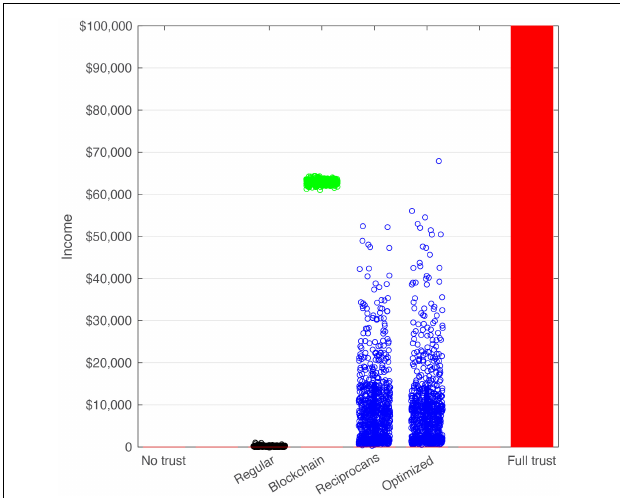
FIGURE 7 | Profit generated by the C-3PO in each simulation condition. Red bar depicts the maximum possible payoff in a 1,000-iteration game with full trust, where each agent contributes all their wages to the shared account (1,000 × $100). Dots reflect the ultimate outcome of a game played with the simulation variables. "No trust” (left) yields $0 for the C-3PO. Regular games (black) yield low gains compared to the Blockchain (green), Reciprocans and Optimized (blue) implementations.